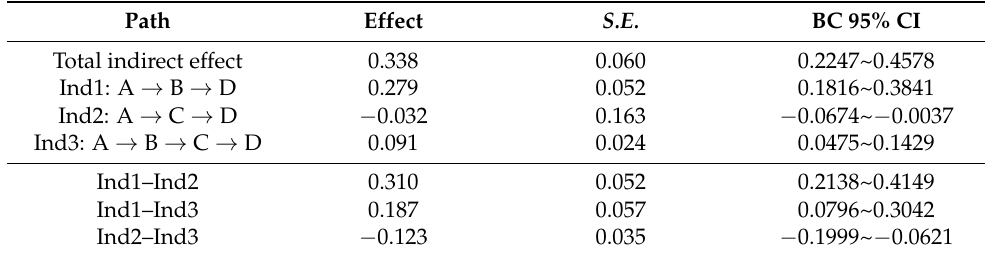
Table 4. Indirect effects of the mediation model.